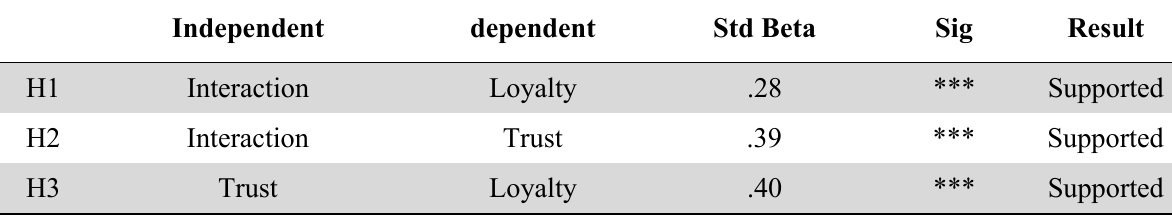
Results of structural model hypotheses